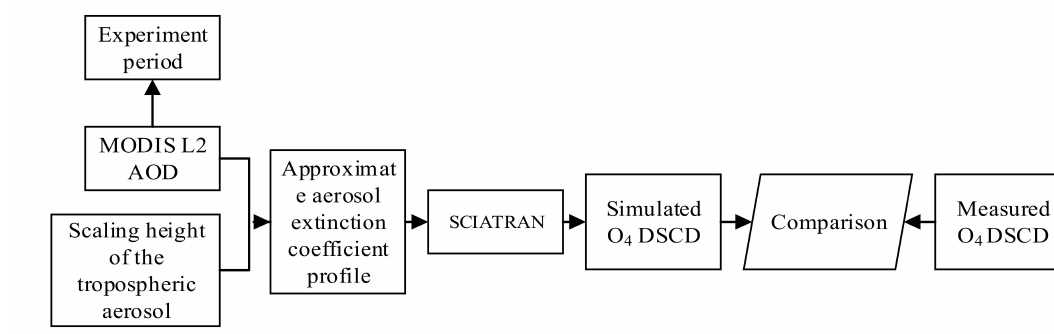
Figure 2. Flow chart for the aerosol extinction coefficient profile and tropospheric NO 2 and HCHO VCD retrieval process.